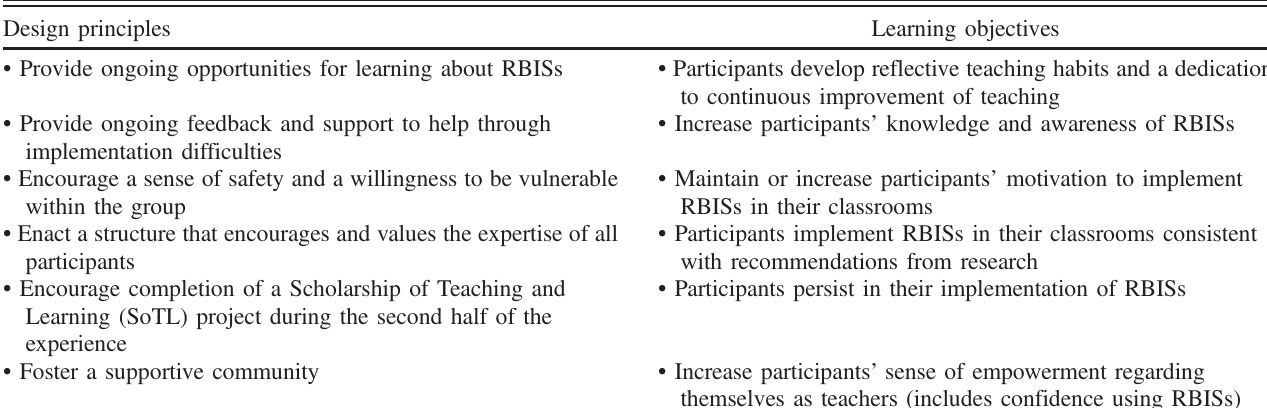
TABLE I. The NFW-FOLC design principles and learning objectives. The design principles often serve multiple objectives. Design principles Learning